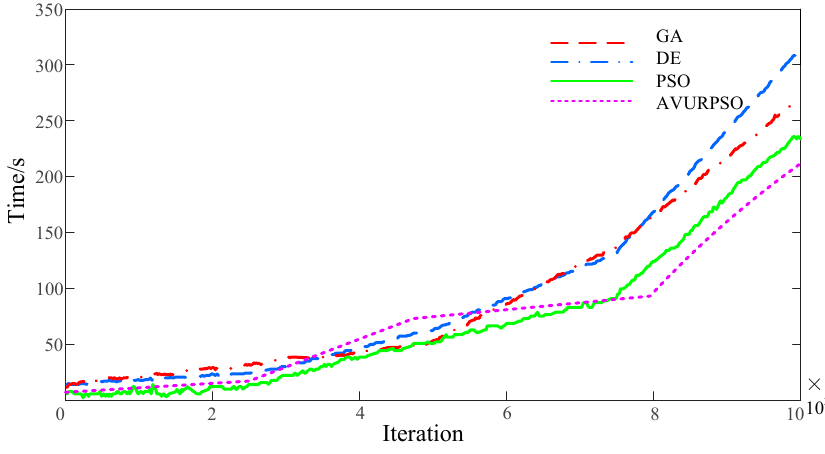
Figure 16. Iteration times of different algorithms.